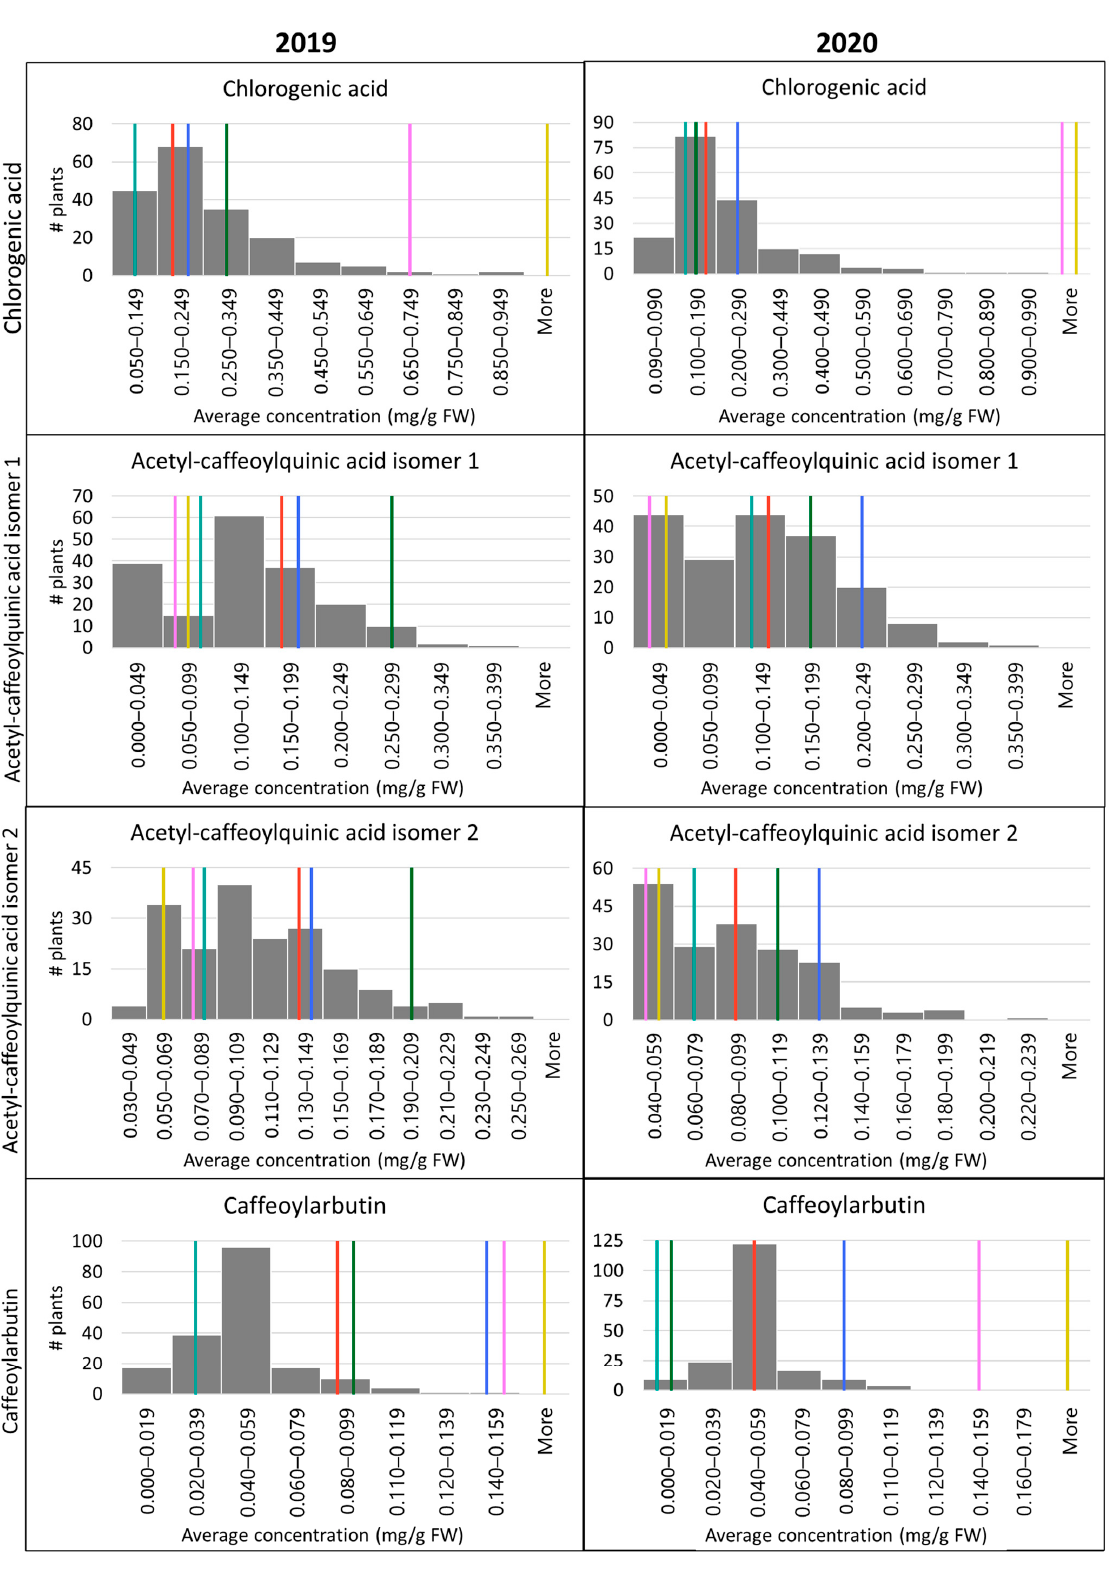
Figure 3. Range and frequency of concentrations of tested compounds in the BNJ16-4 population (mg/g fresh weight). Values from the grandparents and F 1 s are noted with vertical lines in the appropriate bins: OPB-8 (teal), OPB-15 (green), NJ88-14-03 (pink), NJ88-12-41 (yellow), BNJ05-218-9 (red) and BNJ05-237-8